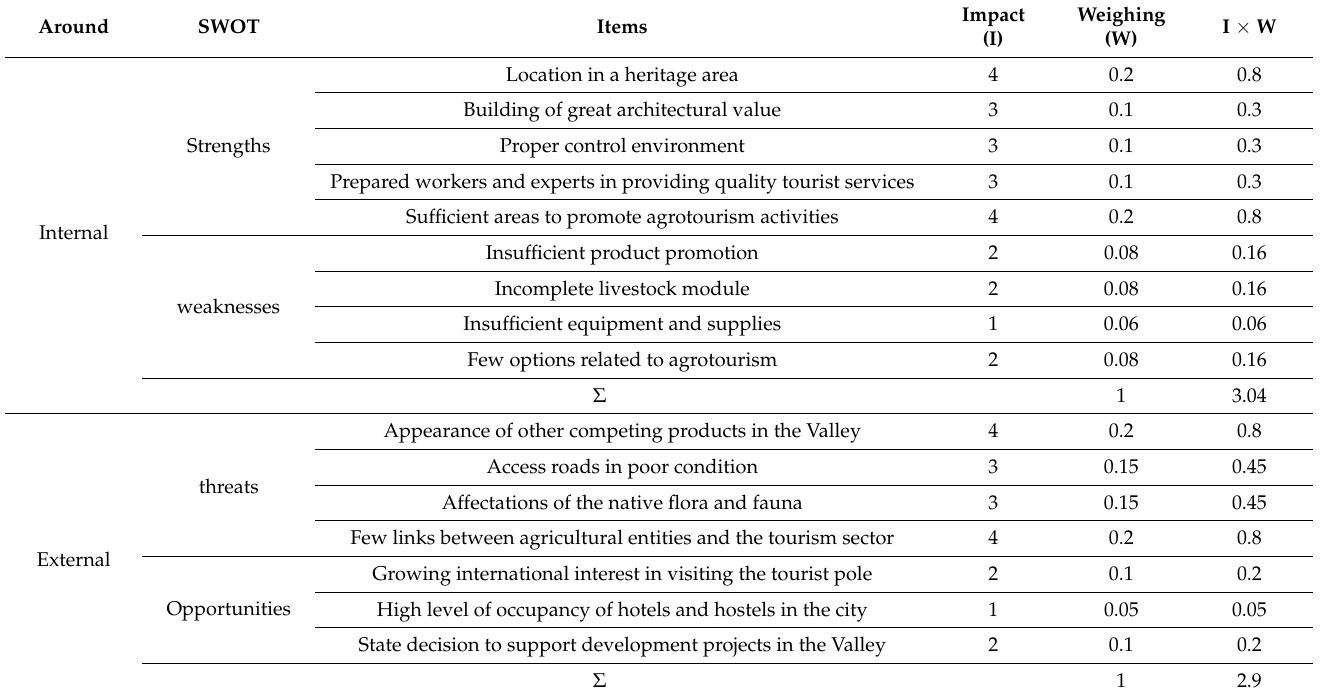
Table 2. Strengths and weaknesses of the internal environment and threats and opportunities of the external environment of the